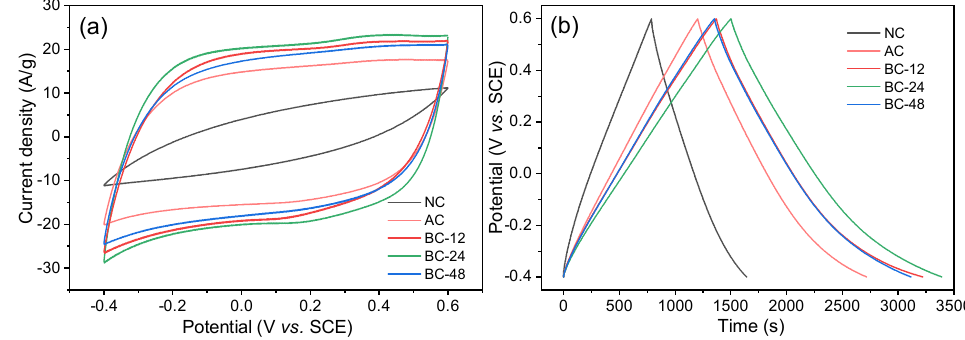
Figure 5. ( a ) CV curves at 100 mV/s and ( b ) GCD tests at 0.2 A/g for the different biochar electrodes.